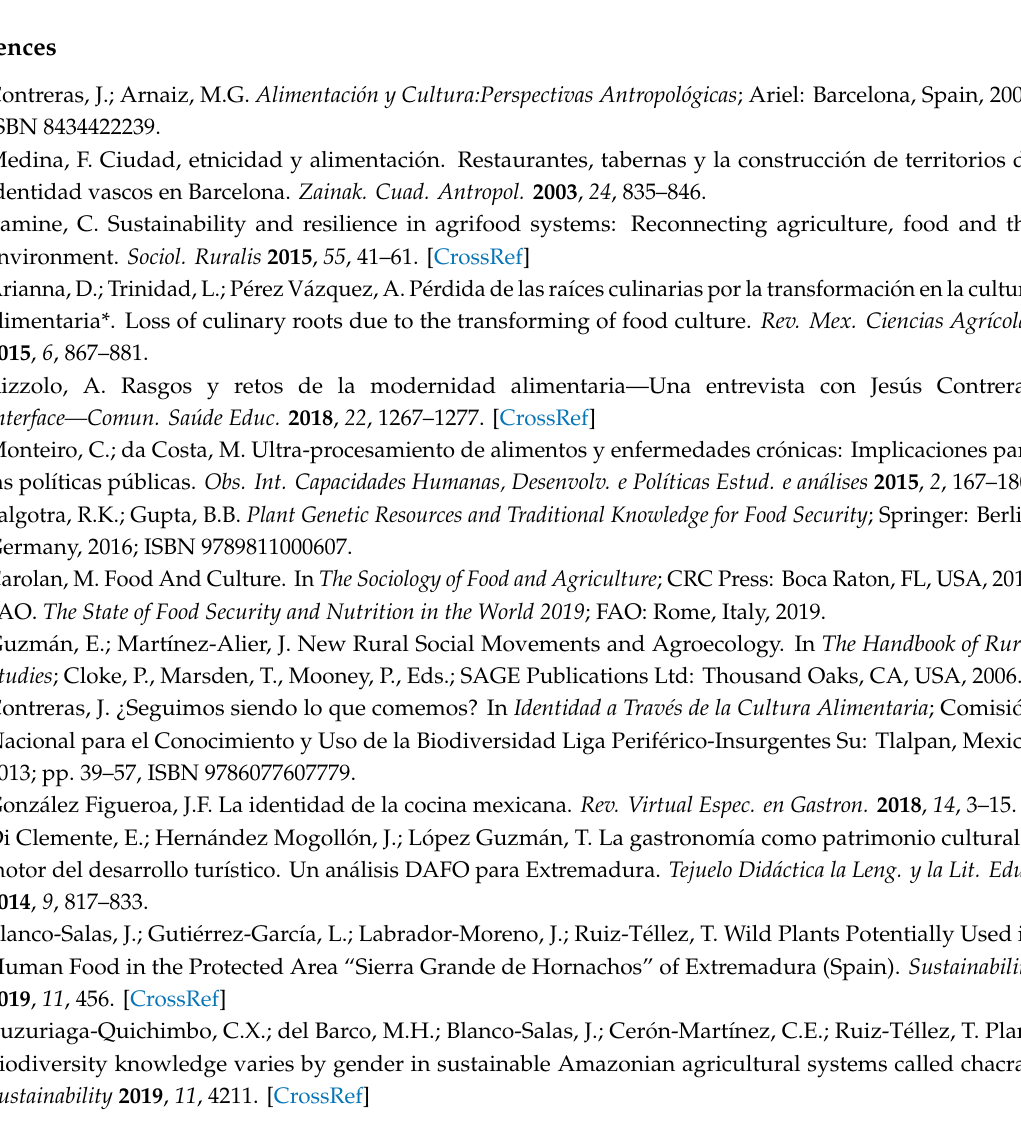
Table S1: Row data calculations for CSIm and CSIw (cultural significance indexes for men and women, respectively) of the 79 plants used in our